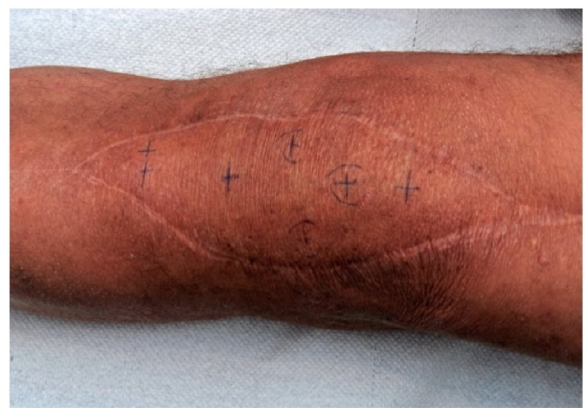
Figure 19: Free s-ELA: Anterior view of the right knee after extended lateral arm flap showing excellent sensation medially and intermediate reinnervation laterally after 12 months (Table 1: Patient No. 3; additional Figures 5, 7, 8, 9,